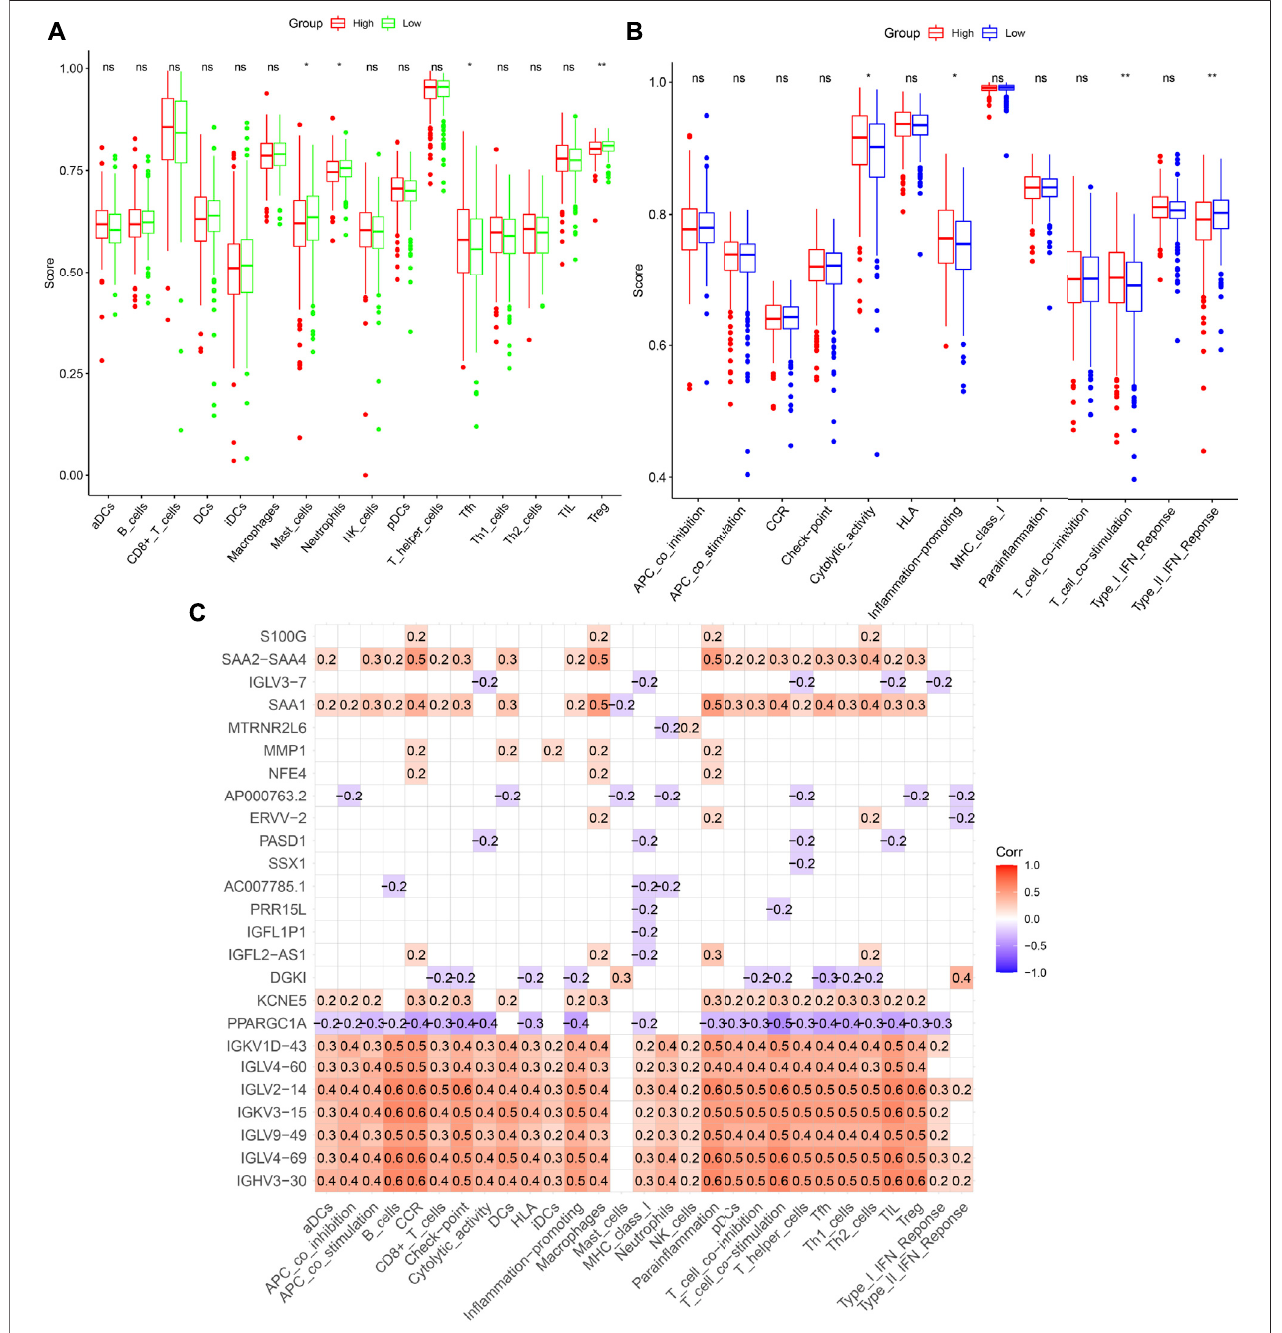
FIGURE10| Immunein fi ltrationanalysis. (A,B) Comparisonofenrichmentscoresofimmunecellsandpathways. (C) Correlationbetweenprognosis-relatedDEGs and immune cells or pathways. The number in the grid indicates the correlation coef fi cient. Red represents positively correlated, while violet represents negatively